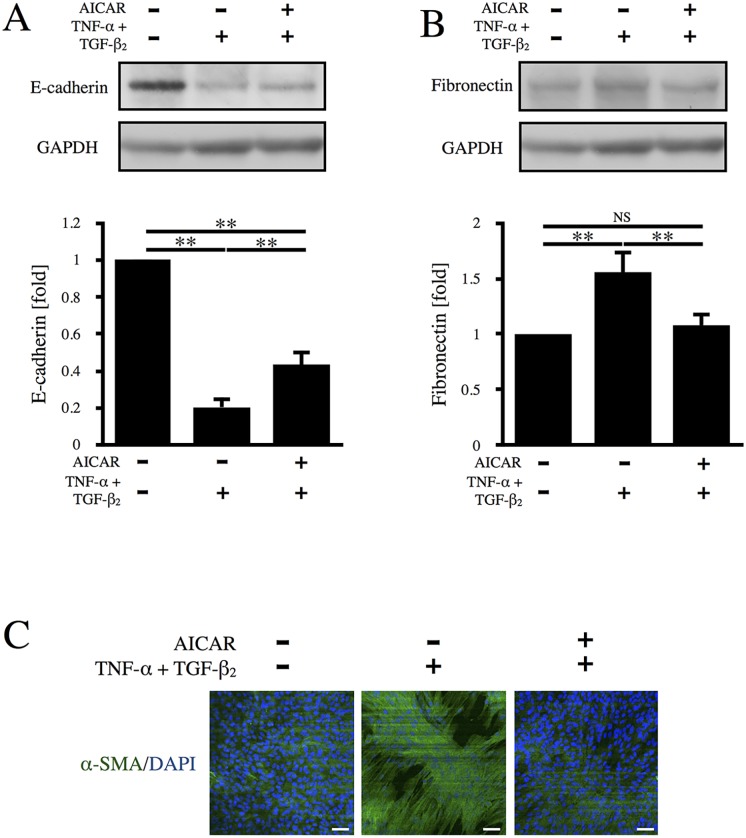
Effect of AICAR on the TNF-α/TGF-β2-induced EMT.Levels of E-cadherin (A) and fibronectin (B) were determined by western blot analysis. (C) Representative images of immunocytochemical staining for α-SMA. Nuclei were counterstained with DAPI. Scale bars = 50 μm.